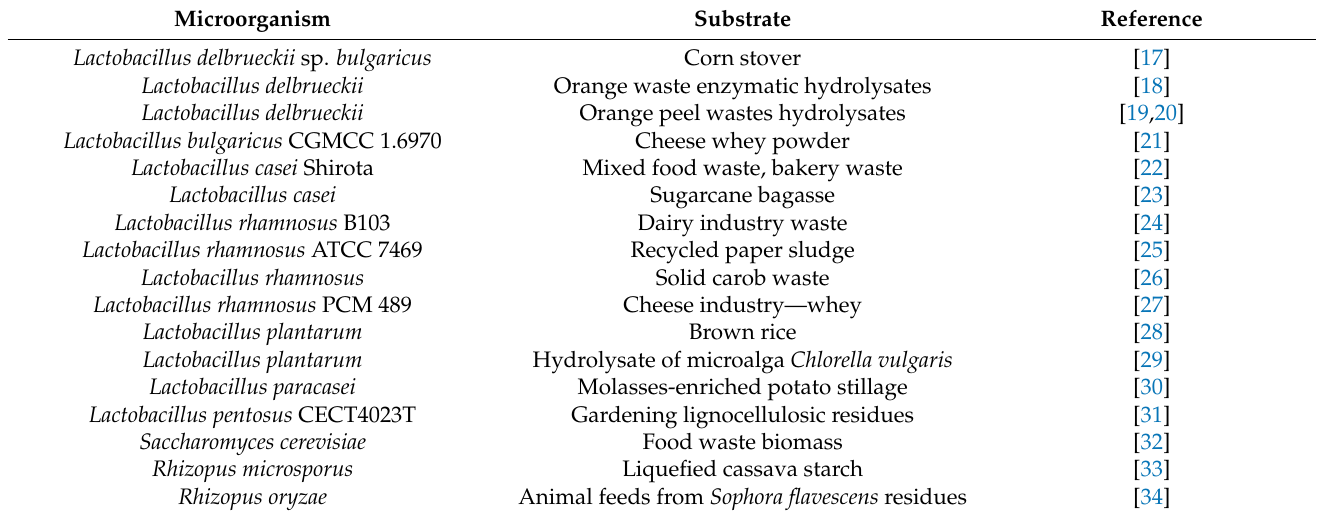
Table 1. Lactic acid-producing microorganisms along with their